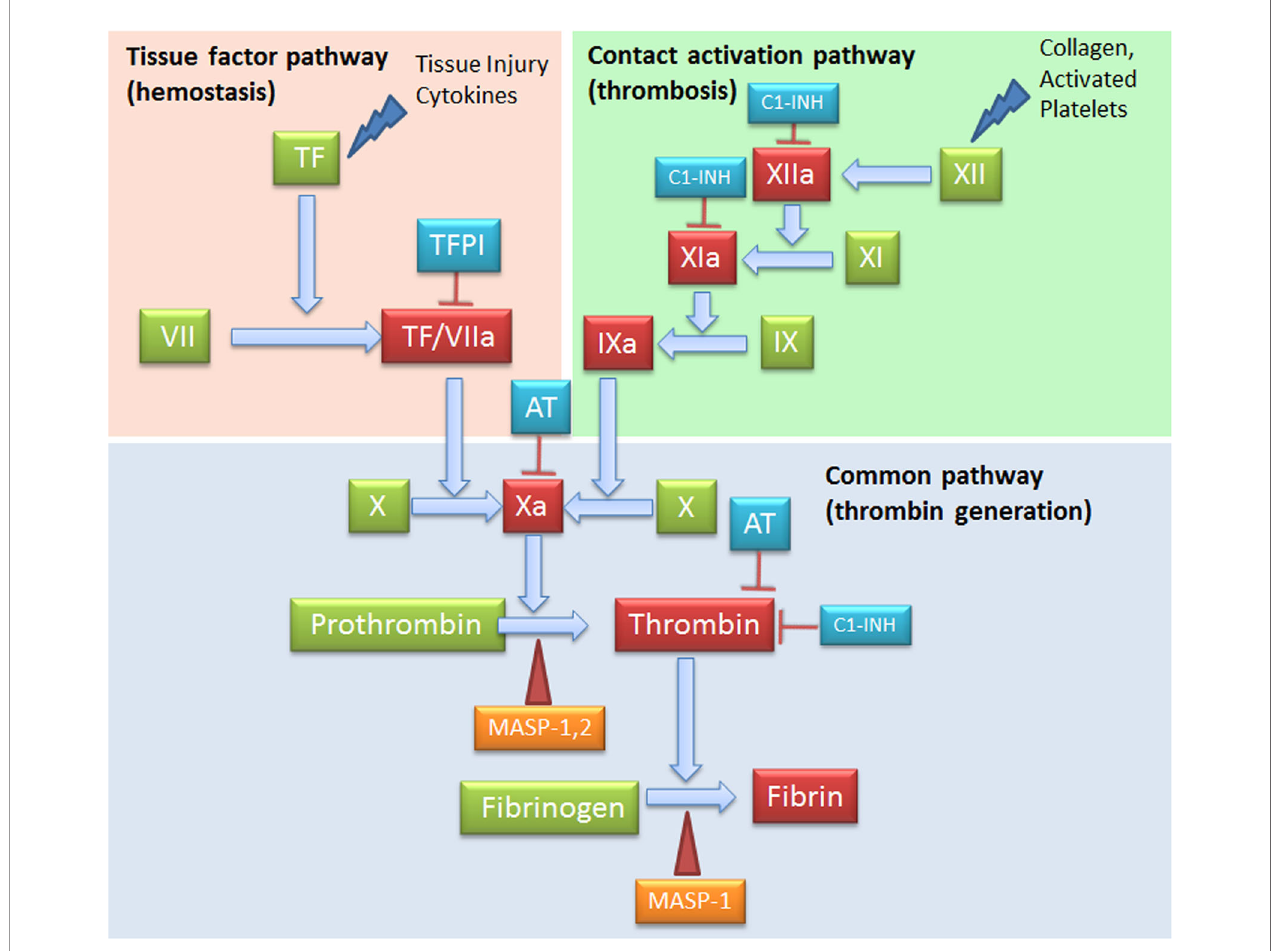
FIGURE 4 | Complement Components that act on the coagulation system. The intrinsic (FXII) and the extrinsic (TF/thromboplastin) pathways initiate the coagulation cascade, both converging at the common point of FX activation. FXa is causes prothrombin (FII) activation in thrombin (FIIa), which leads to the formation of fi brin from the soluble fi brinogen. MASP-1 and MASP-2 directly activate thrombin by cleaving prothrombin, and MASP-1 is able to cleave fi brinogen to generate fi brin monomers. C1-INH exerts its inhibitory activity on the coagulation system by acting on FXIIa, FXIa and thrombin. AT, Antithrombin; C1-INH, C1-inhibitor; MASP, MBL (mannose binding lectin) associated serine protease; TF, Tissue factor; TFPI, Tissue factor pathway